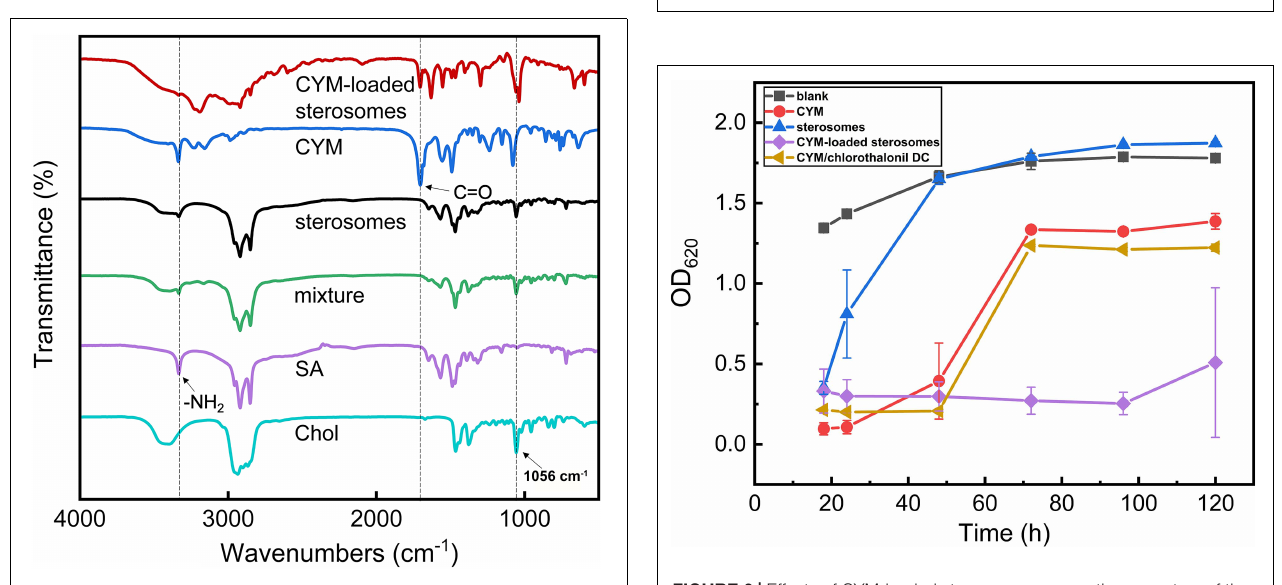
with the pure sterosomes added during the early stage of yeast growth, resulting in the right shift of the yeast growth curve, and it was then consistent with the blank group after 48 h. After sterosomes were added, yeast cells aggregated in the culture